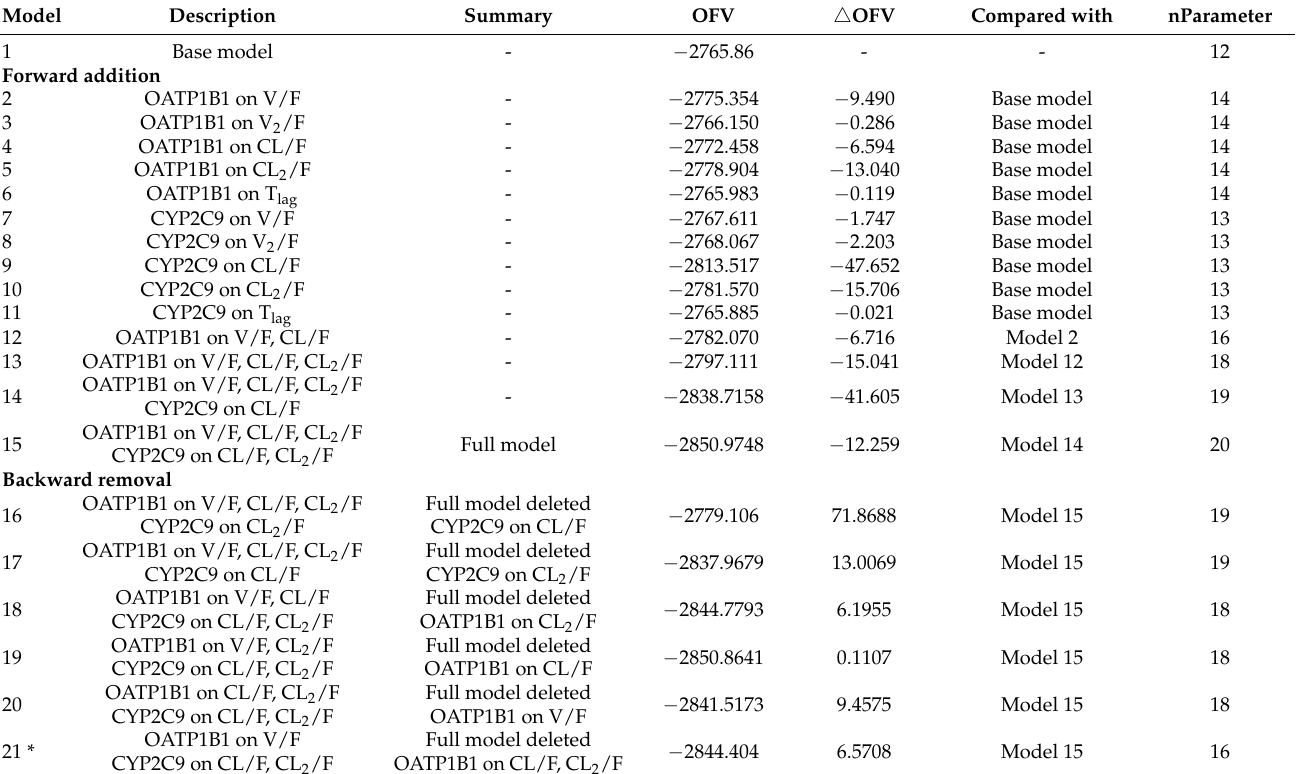
Table 3. Stepwise selection of covariates for the Pop-PK model of